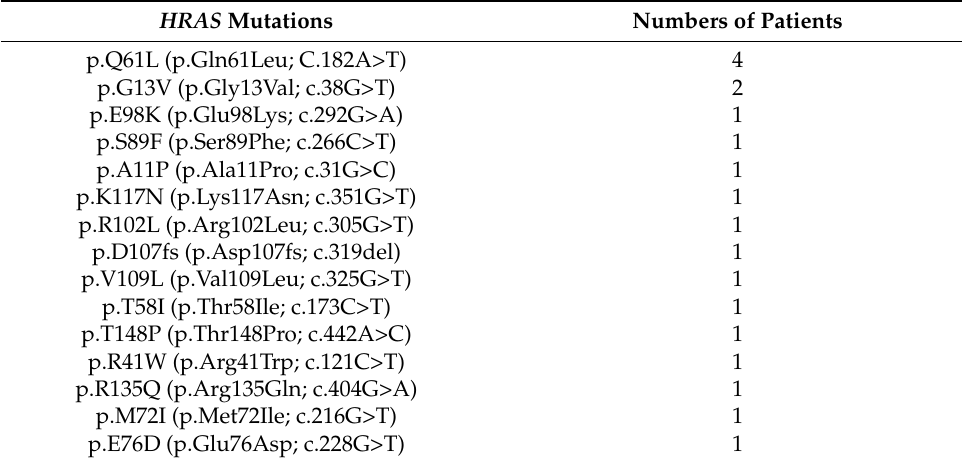
Figure 1. Flowchart. NGS: Next-Generation Sequencing. Table 1. HRAS mutations type among all 19